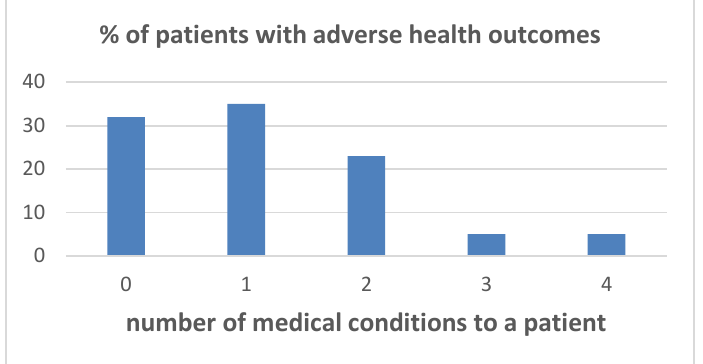
Figure 3. Adverse health outcomes.